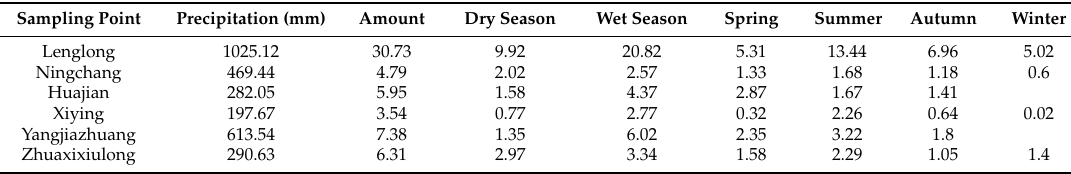
Table 7. The wet deposition flux of the sulfur element (mg / dm 2